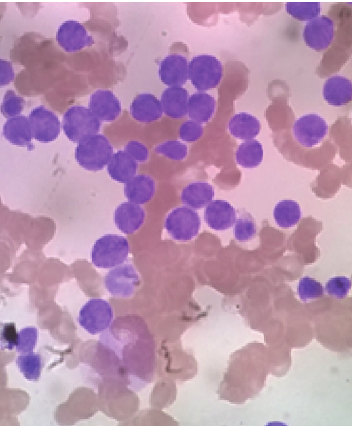
Figure 2: H7E × 100 Section from nodular skin lesion showing infiltration by leukemic cells.